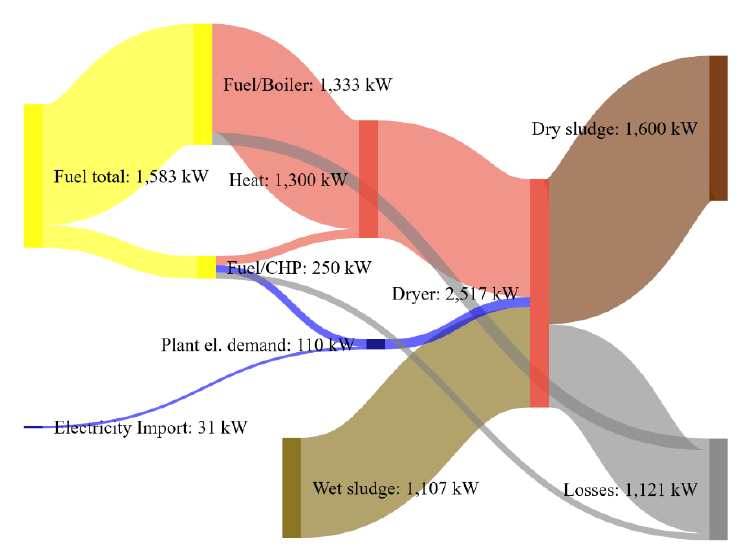
Figure 6. Energy flows in the drying plant—case 2.